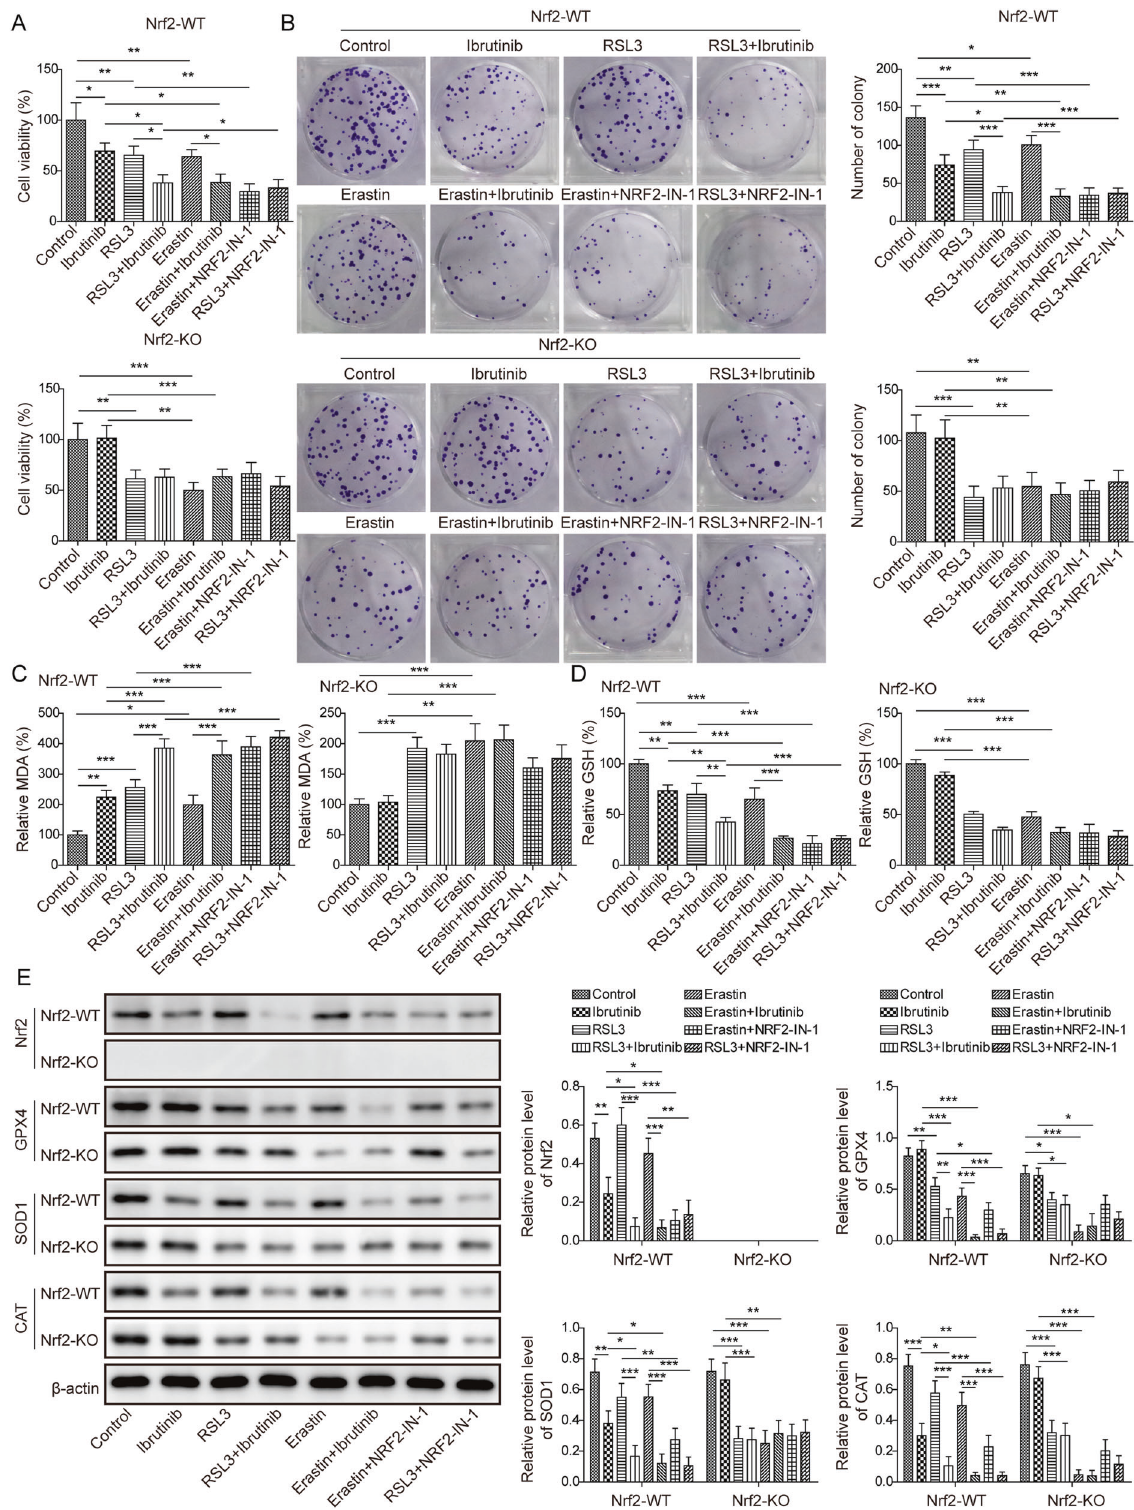
Fig. 5 Nrf2 plays a critical role in Ibrutinib regulates the sensitivity of CRC cells to RSL3 or Erastin-induced ferroptosis. The impact of Nrf2 knockout on the A viability and B proliferation of HT-29 and Caco-2 cells that were treated with Ibrutinib, RSL3, Erastin, Ibrutinib/RSL3, Ibrutinib/Erastin, NRF2-IN-1/RSL3, or Erastin/NRF2-IN-1 detected by the CCK-8 assay and the colony formation assay. The impact of Nrf2 knockout on the C MDA and D GSH levels in the HT-29 and Caco-2 cells that were treated with Ibrutinib, RSL3, Erastin, Ibrutinib/RSL3, Ibrutinib/Erastin, NRF2-IN-1/RSL3, or Erastin/NRF2-IN-1. E The impact of Nrf2 knockout on Nrf2, GPX4, SOD1 and CAT expressions in HT-29 and Caco-2 cells that were treated with Ibrutinib, RSL3, Erastin, Ibrutinib/RSL3, Ibrutinib/Erastin, NRF2-IN-1/RSL3, or Erastin/NRF2-IN-1. All experiments were carried out at least three times, n = 3, * P < 0.05, ** P < 0.01 and *** P < 0.001.